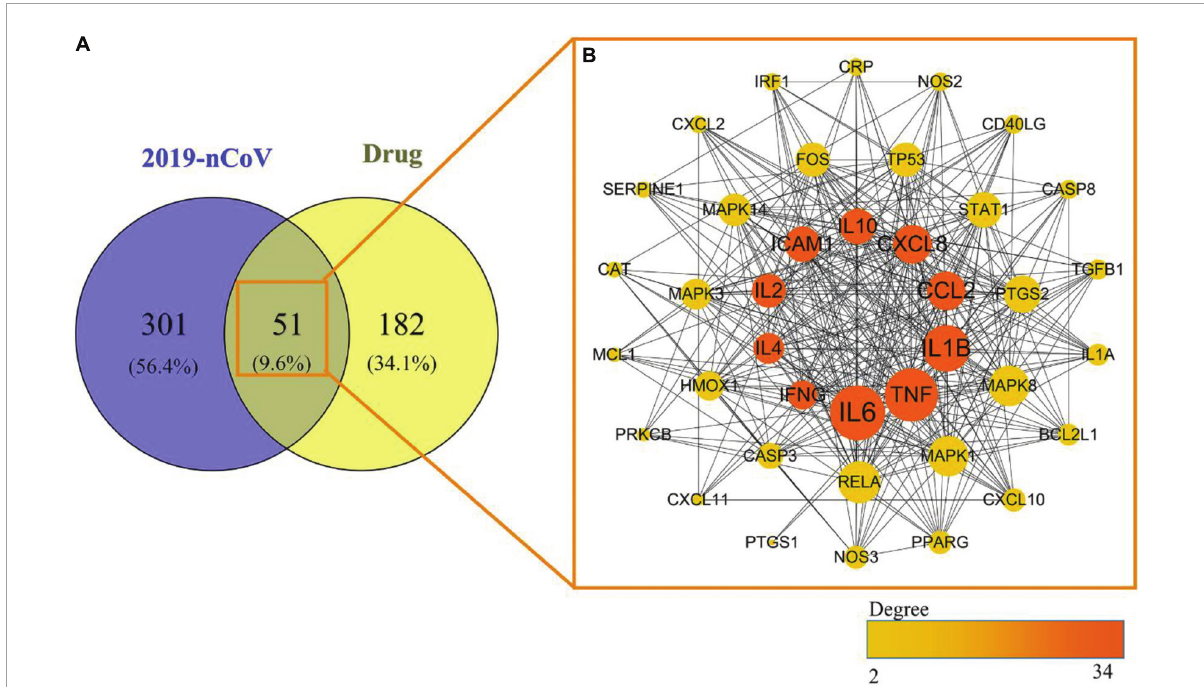
FIGURE3 Mapping relationships between the four recommended CPMs and COVID-19. (A) Intersection targets of COVID-19 and four CPMs. (B) Protein interactions among 51 potential targets. The node’s size indicates the target’s degree, and the larger the node is, the higher the importance is. The thicker edges suggest stronger interactions. The degree value of nodes is positively correlated with node size and color brightness. The middle 10 targets are Hub genes screened based on the MCC method.